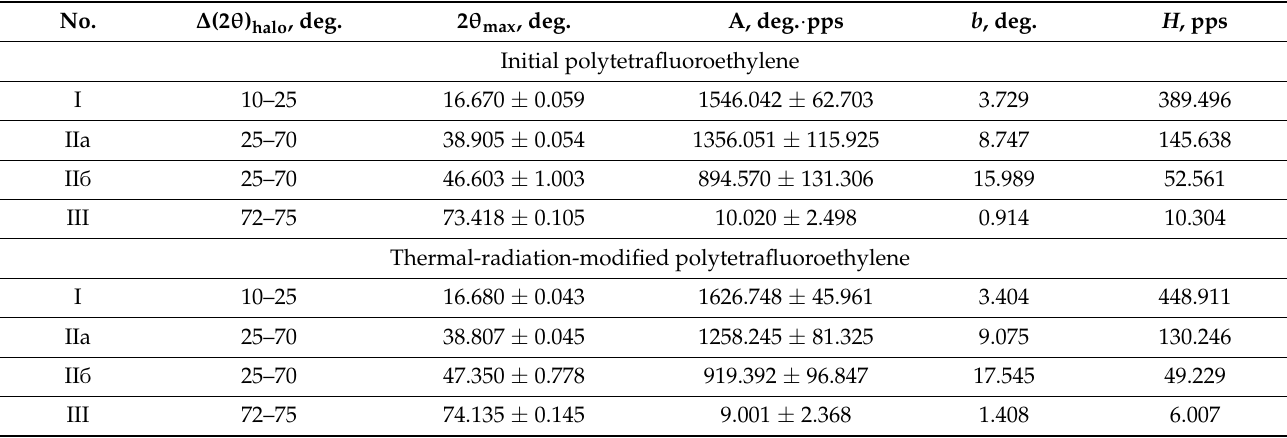
Table 3. Diffuse diffraction maxima in the X-ray scattering spectrum of the initial and thermal-radiation-modified polyte- trafluoroethylene samples and its